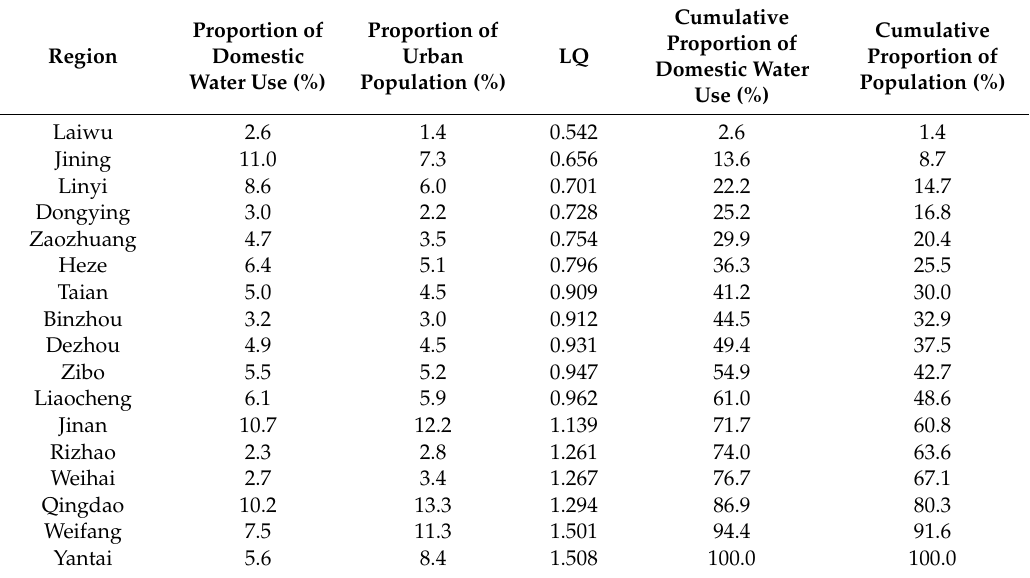
100.0 Cumulative Proportion of Population (%)